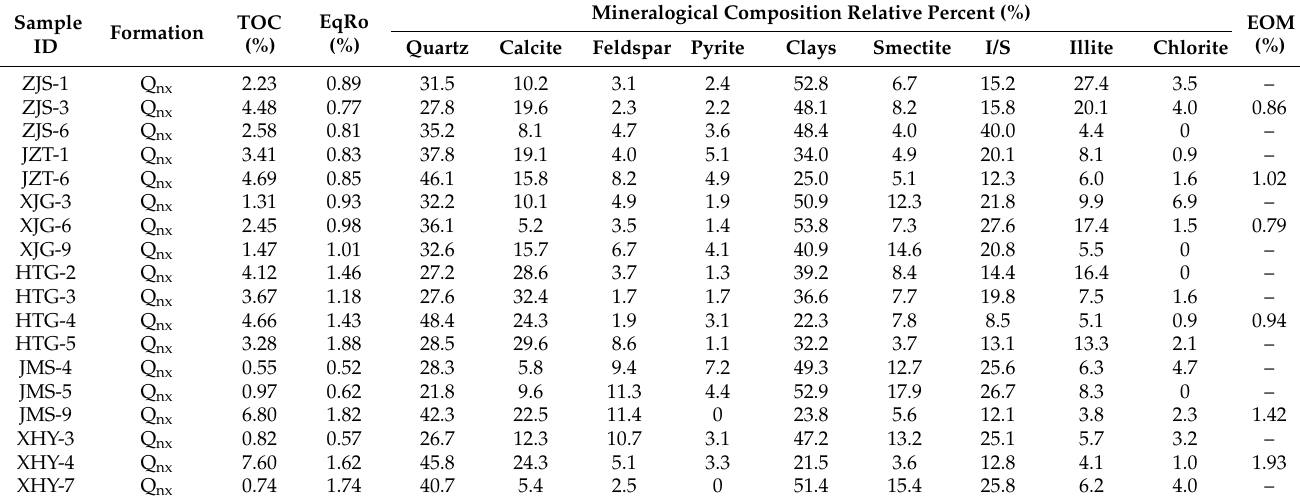
Table 1. Geochemical information and mineralogical composition for the investigated Xiamaling